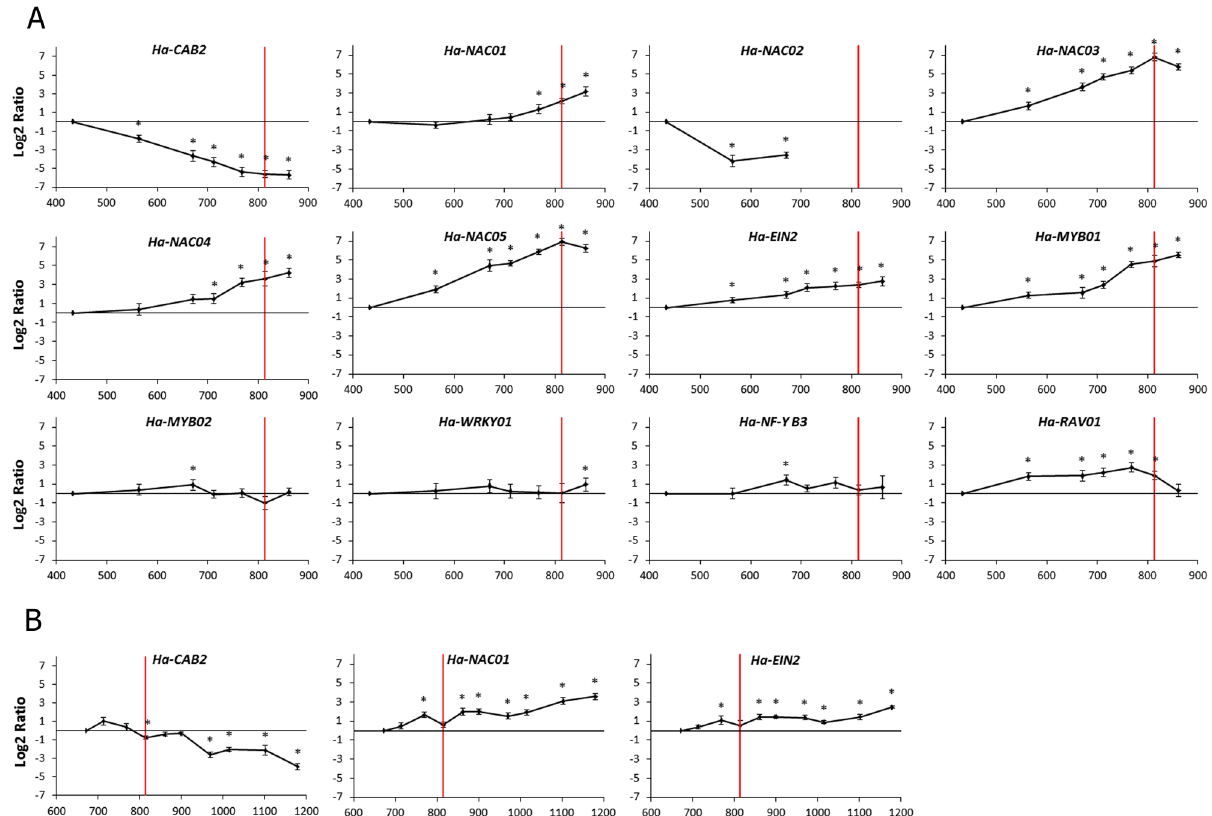
Figure 1. qPCR expression data. (A) Leaf 10. (B) Leaf 20. Relative transcript level for each candidate gene at different sampled points determined by qPCR. The x –axis showed the thermal time after emergence ( u Cd). Asterisks indicate significant difference between each sampling in relation to first sampling point (S-1) and reference genes (p-value , 0.05). The red line indicates anthesis time. Error bars correspond to standard errors.